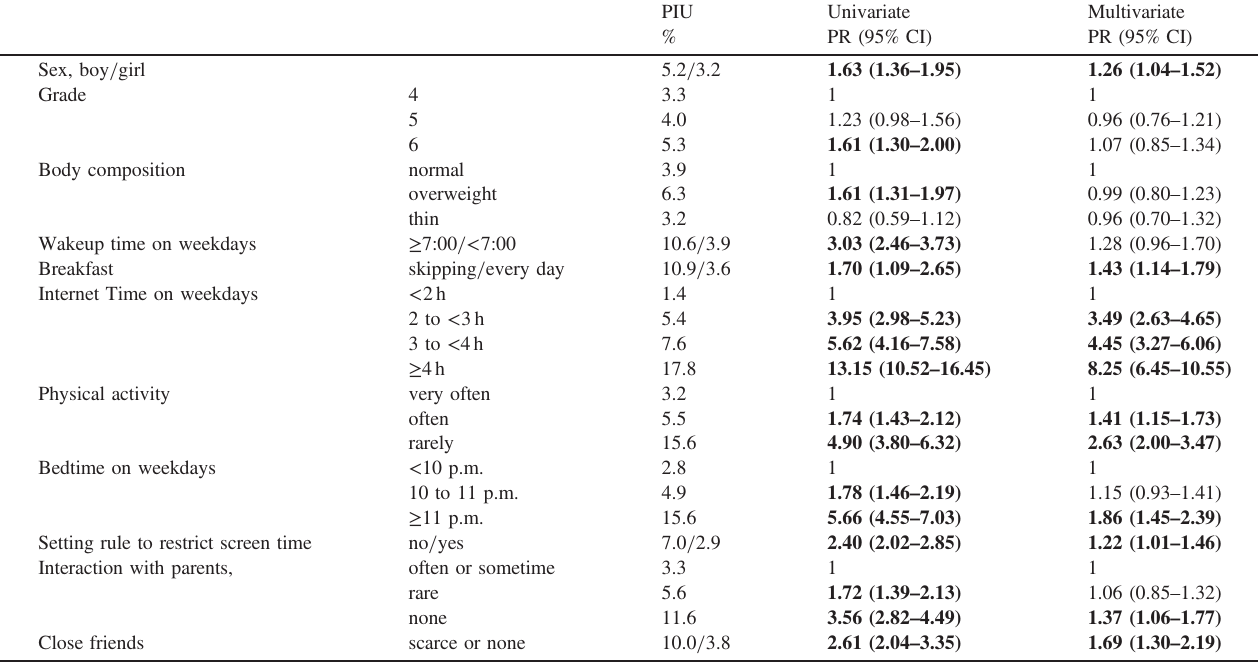
Table 2. Poisson regression analyses on pathological Internet use, n = 12,130